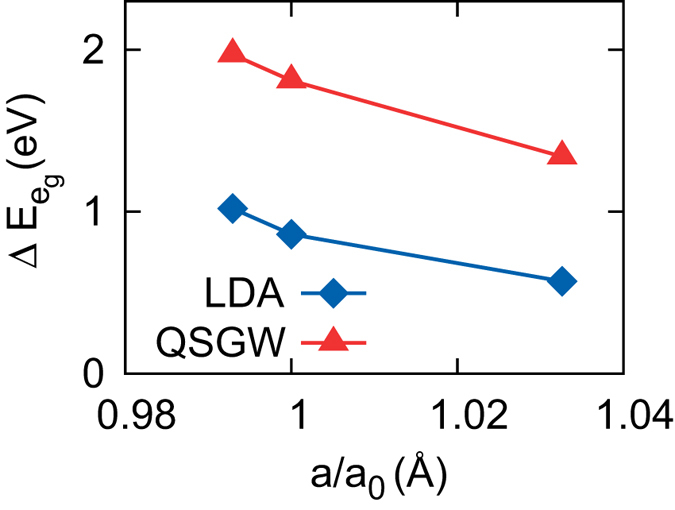
The calculated  as a function of epitaxial strain. The a0 = 3.782 Å is the experimental value for bulk La2CuO4.The compressive and tensile strain are simulated with a = 3.755 and 3.905 Å considering the substrate of SrLaAlO4 and SrTiO3, respectively44.